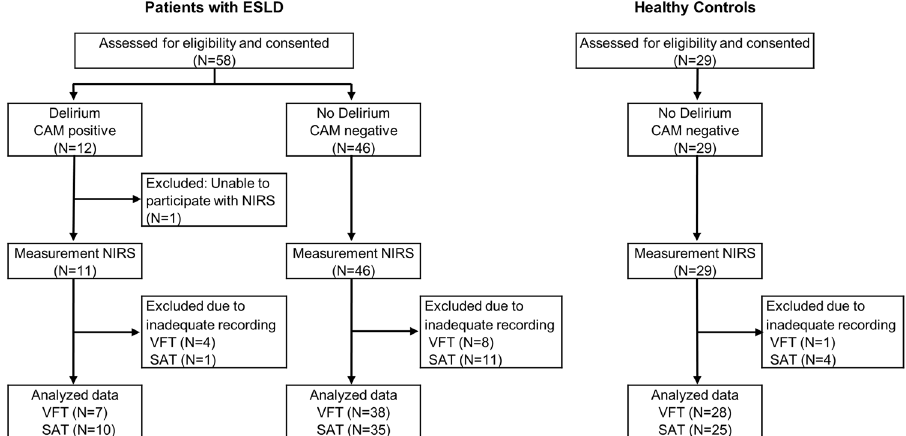
Figure 1. Consort diagram of participants. Near-infrared spectroscopy (NIRS) measurements were defined as inadequate when 11 channels or more contained artifacts. ESLD: End Stage Liver Disease; CAM: Confusion Assessment Method; VFT: Verbal Fluency Task; SAT: Sustained Attention